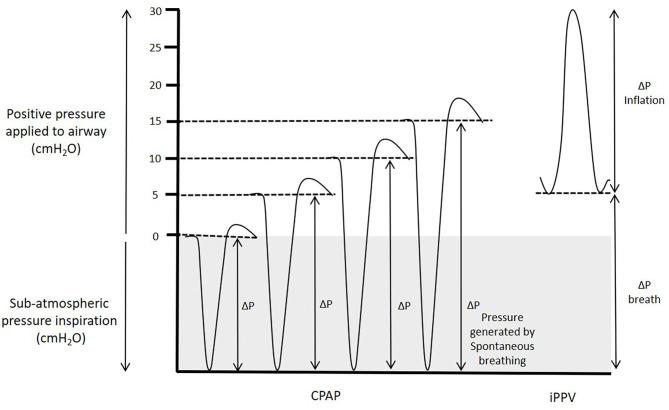
Pressure generated during CPAP and iPPV. Transpulmonary pressures (ΔP) are the primary factor that drives lung aeration after birth. During spontaneous breathing, thoracic expansion generates sub-atmospheric intrathoracic pressures, which when combined with CPAP increase the effective transpulmonary pressure applied to the lung. While intrathoracic pressures must transiently increase above the CPAP level to effect expiration, the CPAP level is effectively the highest external pressure applied to the airways and the mean intrathoracic airway pressure is considerably lower than the CPAP level. In contrast, during iPPV, PEEP is the lower limit of the applied pressure to the airways and the transpulmonary pressure that drives airway liquid clearance results from pressure increases above PEEP resulting in a mean airway pressure considerably higher than the PEEP.